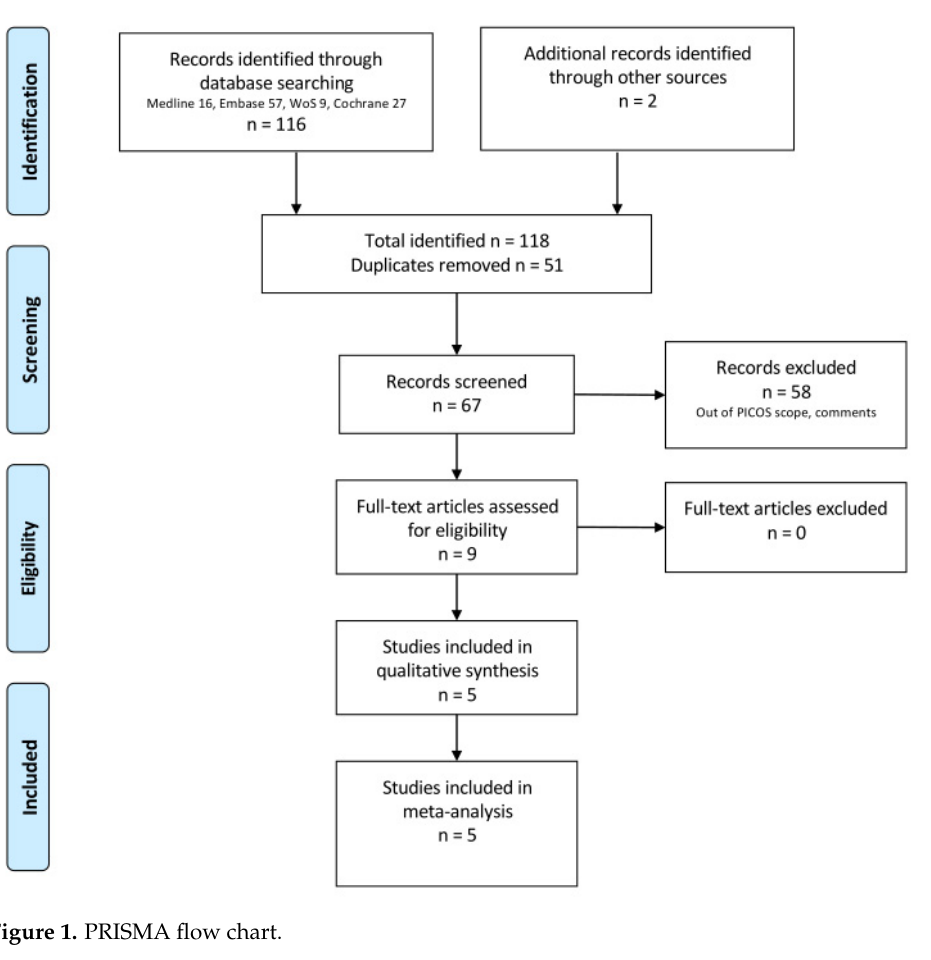
Figure 1. PRISMA flow chart.